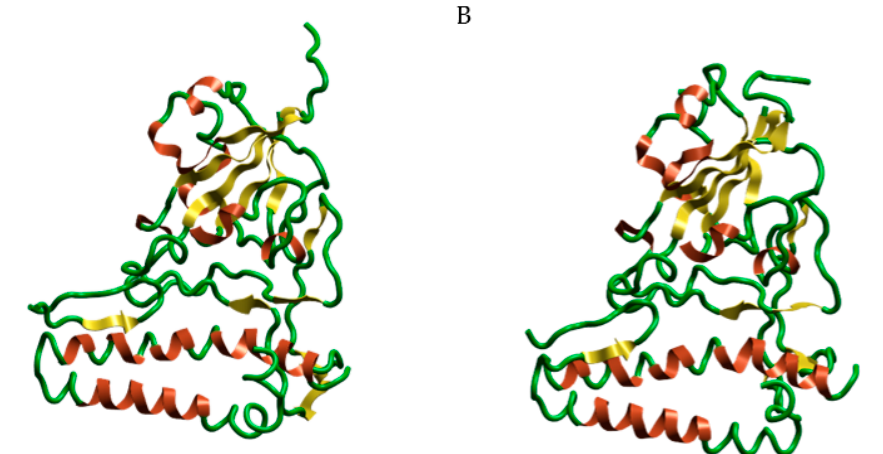
Figure 10. Dynamics studies of MGF (1) and MGF (2) with synergic activity. Panel ( A ) shows the normal structure of the amino acid from Gln388 to Ala443. Panel ( B ) shows the structure of the same portion after the disrupting activity of the synergism of the two MGF molecules. Water and accessory parts of spike and ACE2 were omitted for clarity.